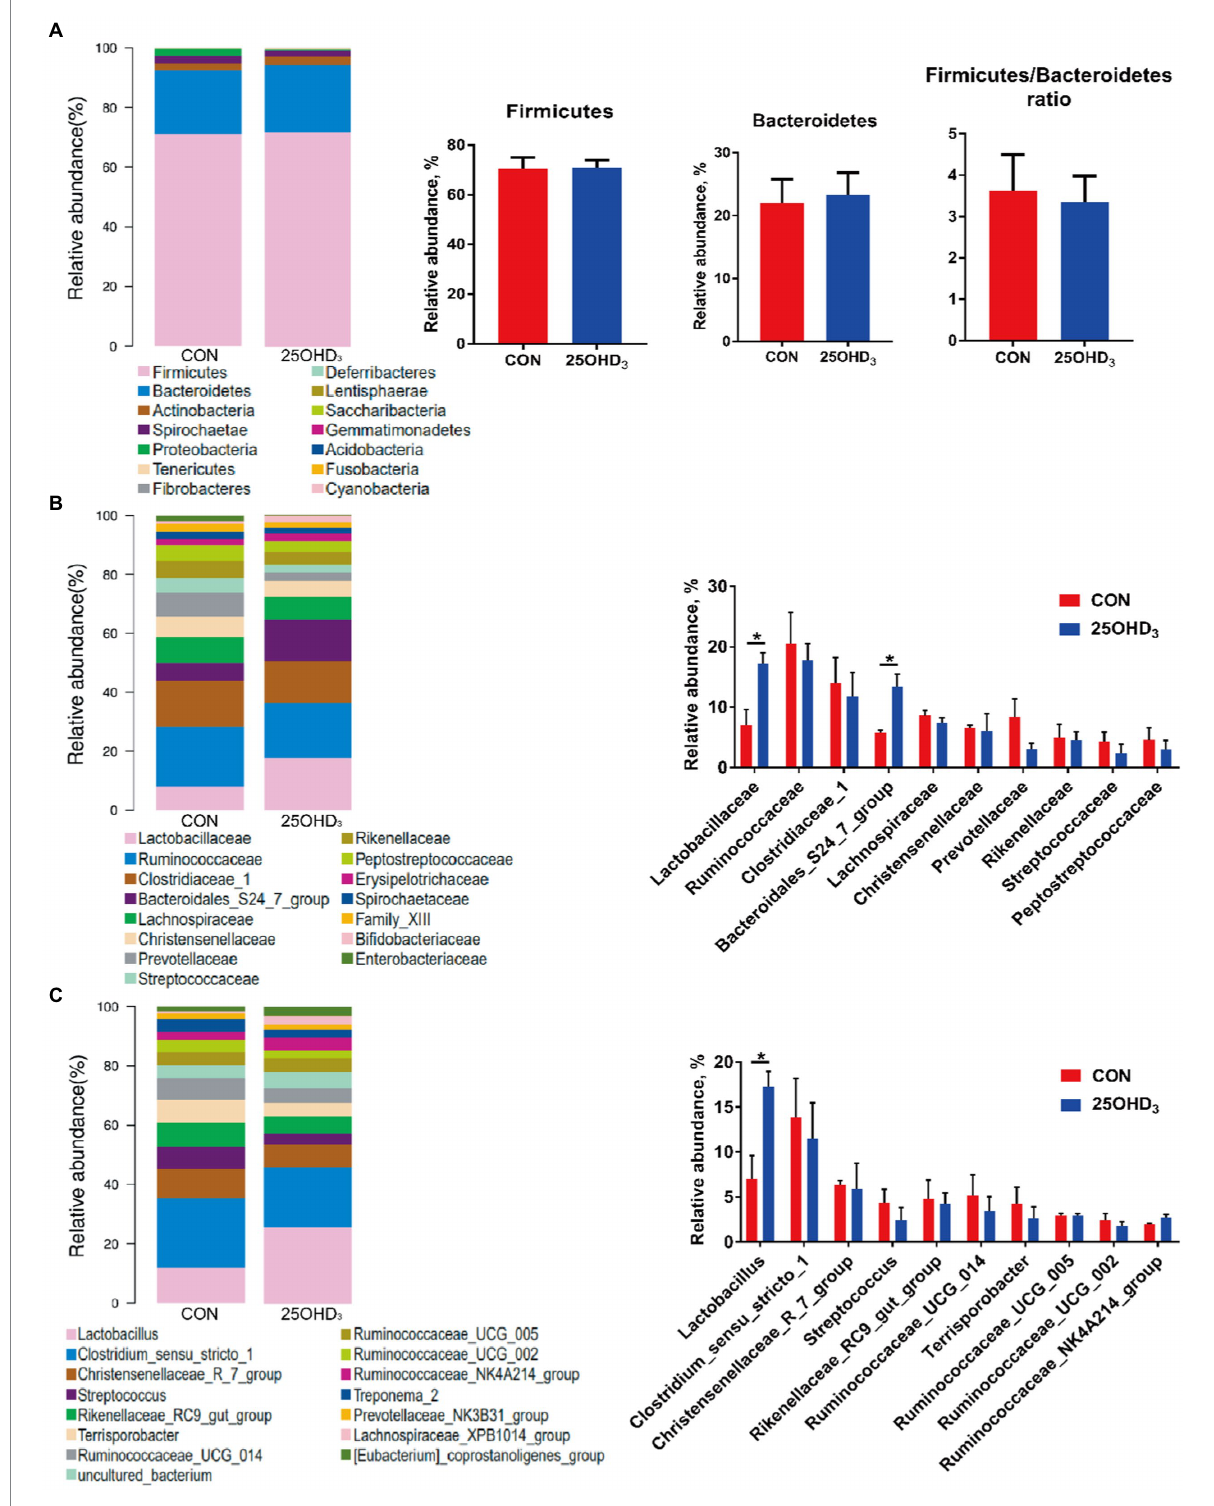
FIGURE 6 The composition of colonic microbiota at the phylum (A) , family (B) and genus (C) levels. Values are shown as the means ± SEM, n = 5. * p < 0.05 versus CON